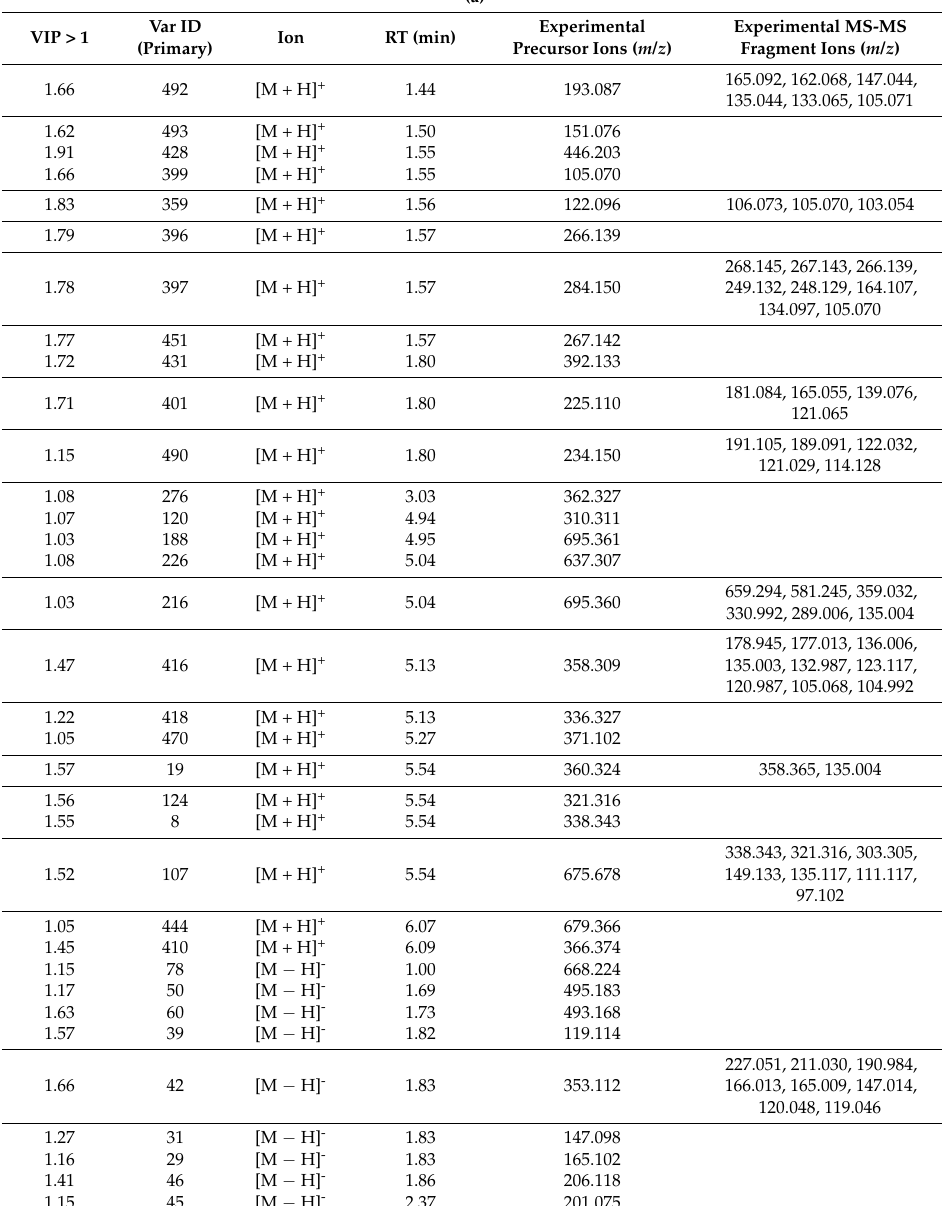
Table 4. (a) List of diagnostic ions for H. itama honey based on UHPLC-QTOF mass spectrometric (c) List of diagnostic ions for T. apicalis honey based on UHPLC-QTOF mass spectrometric